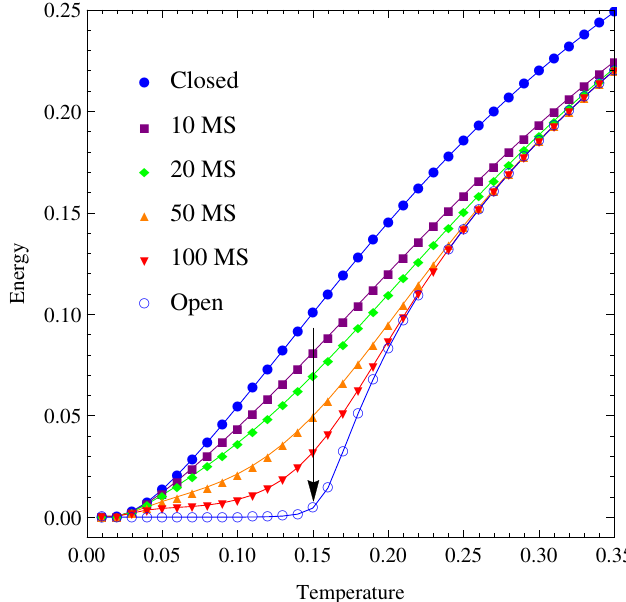
Figure 2. Equilibrium energy per cluster according to the temperature of the closed region with h = h (cid:48) = 0.1 and of the open system with h = 0.1 and h (cid:48) = 1. Between them, isochronal curves of the isothermal evolutions of an initially closed cluster in equilibrium when opened towards its new equilibrium states (arrow) at different times in Markov steps (MS).